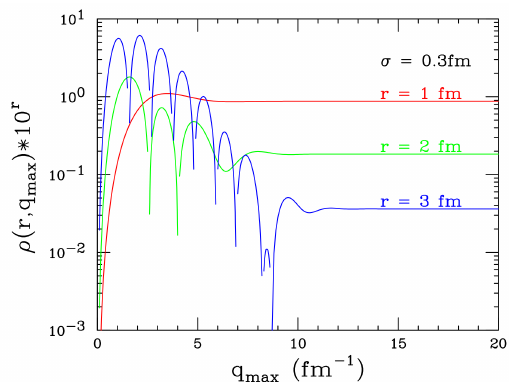
Figure 9. Average density in the region centered on radius r as obtained from the truncated integral over G e ( q )